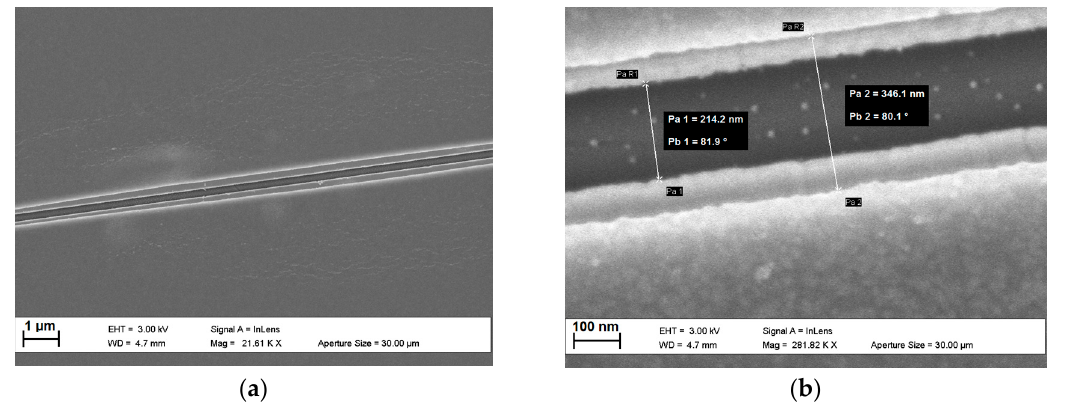
Figure 2. ( a ) SEM image showing a 13 µm section with both the gold electrodes and SU-8 passivation layer visible; and ( b ) measurements of the electrode and passivation layer nanogaps.